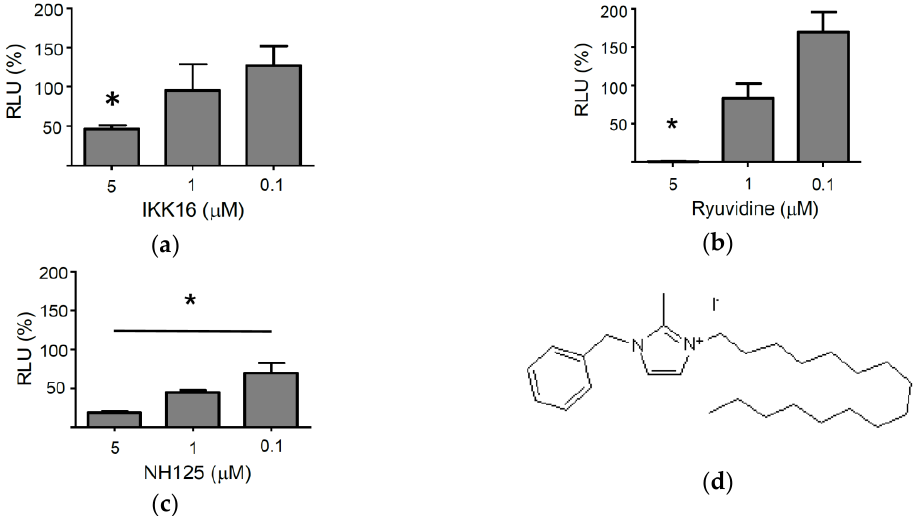
Figure 1. Effect of selected kinase inhibitors on VSV* Δ G(FLuc)-driven reporter gene expression. The three compounds IKK16 ( a ), ryuvidine ( b ) and NH125 ( c ), which showed >95% suppression of VSV-driven firefly luciferase reporter expression when used at 10 µM (supplementary Table S1), were tested for antiviral activity using lower concentrations (5 µM, 1 µM, and 0.1 µM). Vero cells were treated with the compounds at the indicated concentration for 2 h, inoculated for 1 h with VSV*∆G(FLuc) using an m.o.i. of 0.5 and then further incubated with the indicated compounds for six more hours. Luminescence emission was determined in cell lysates for 1 s using luciferin as substrate and expressed as relative luminescence units (RLU). Percentage RLU was calculated using the luminescence emission of DMSO-treated cells as reference. Mean values and standard deviations of three infection experiments are shown. Asterisks indicate significant inhibition of infection (compared to DMSO-treated control cells). ( d ) Chemical structure of NH125 [36].